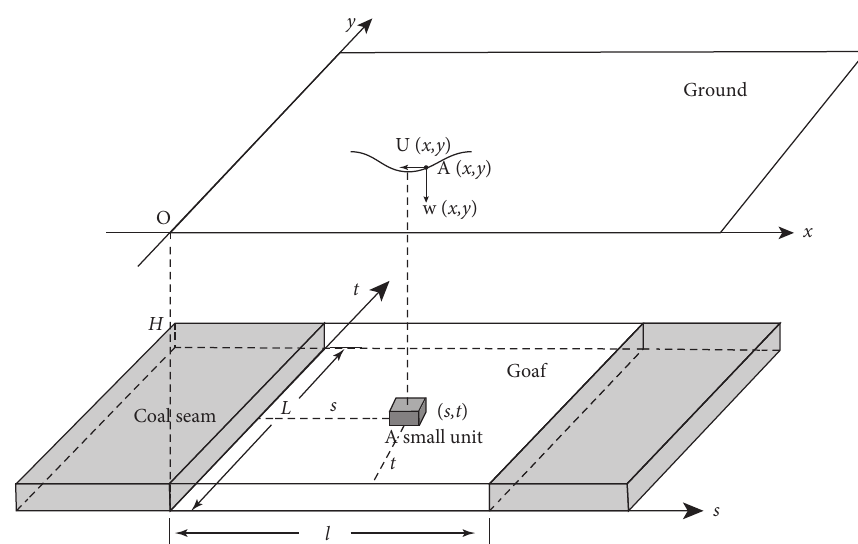
Figure 6: A diagram of surfer movement calculated by PIM.